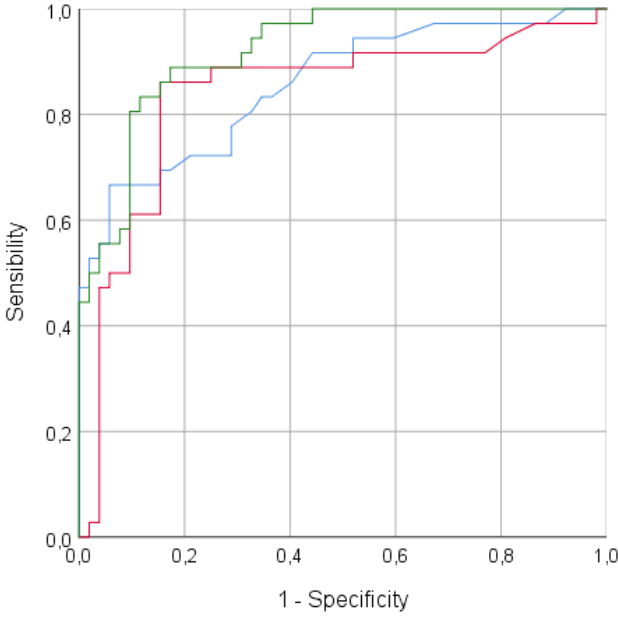
Figure 1. Receiver operating characteristic (ROC) curve for the prediction of bad outcome. Lactate, AUROC 0.86 (95CI: 0.77–0.94) ( p < 0.001); creatinine, AUROC 0.84 (95CI: 0.74–0.93) ( p < 0.001); lactate + creatinine, AUROC 0.92 (95CI: 0.87–0.97) ( p < 0.001). AUROC: Area under the receiver operating characteristic (ROC) curve.